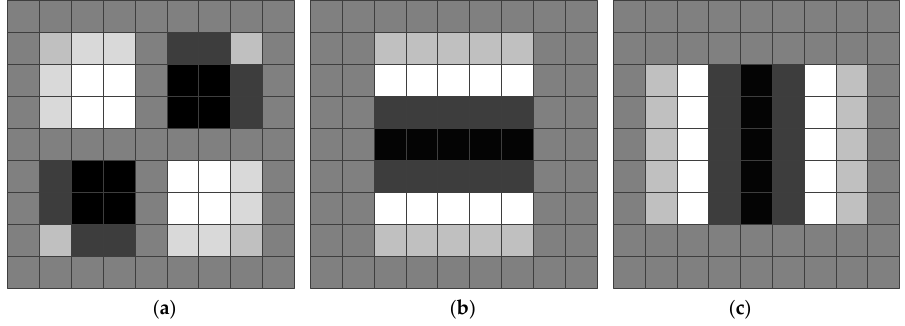
Figure 5. Improved box filter. ( a ) Box filter of D xy (Two order derivatives for X and Y axes) ( b ) Box filter of D yy (Two order derivatives for Y axe) ( c ) Box filter of D xx (Two order derivatives for X axe) .